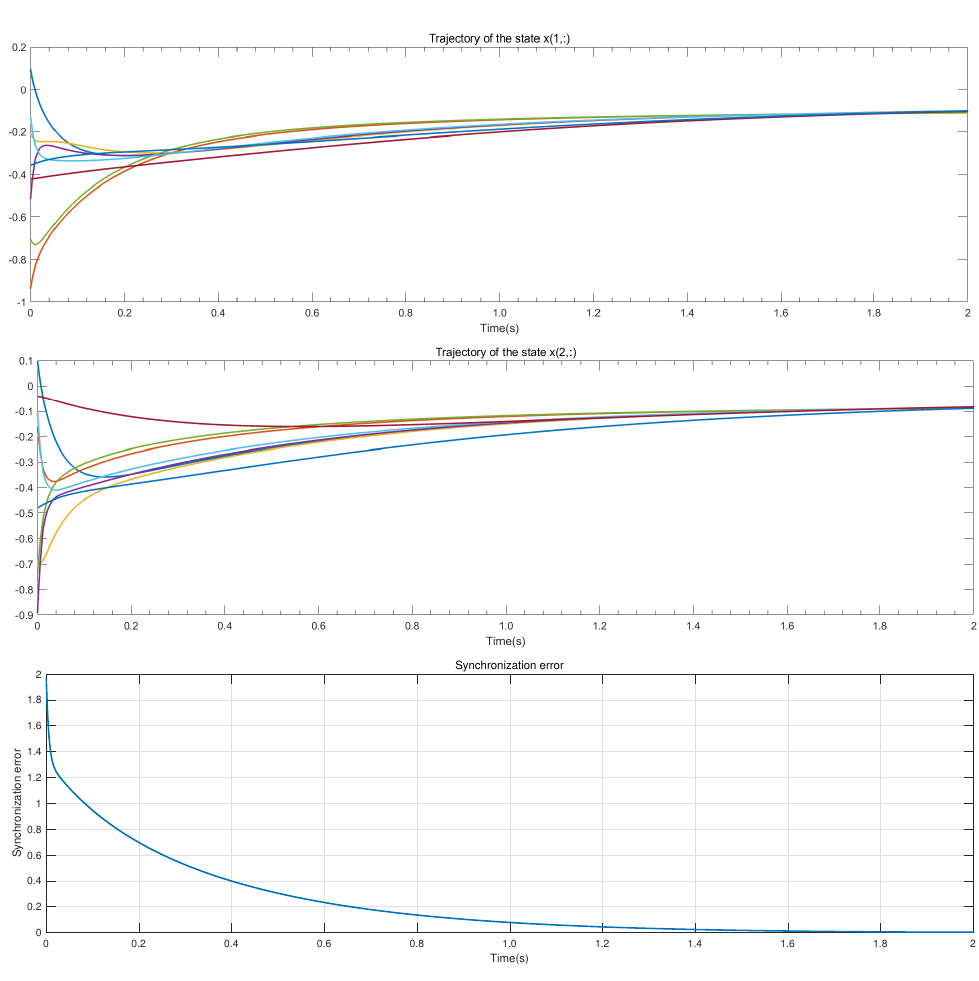
Figure 4. The comparison results of the trajectory graph of synchronization methods in